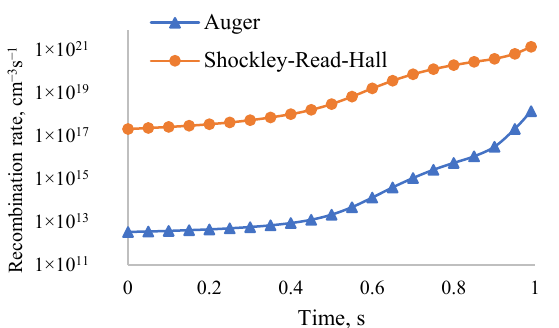
Figure 6. Dependence of SRH and Auger recombination rates of solar cell (200 nm, 60 nm, and 20 nm) on time.